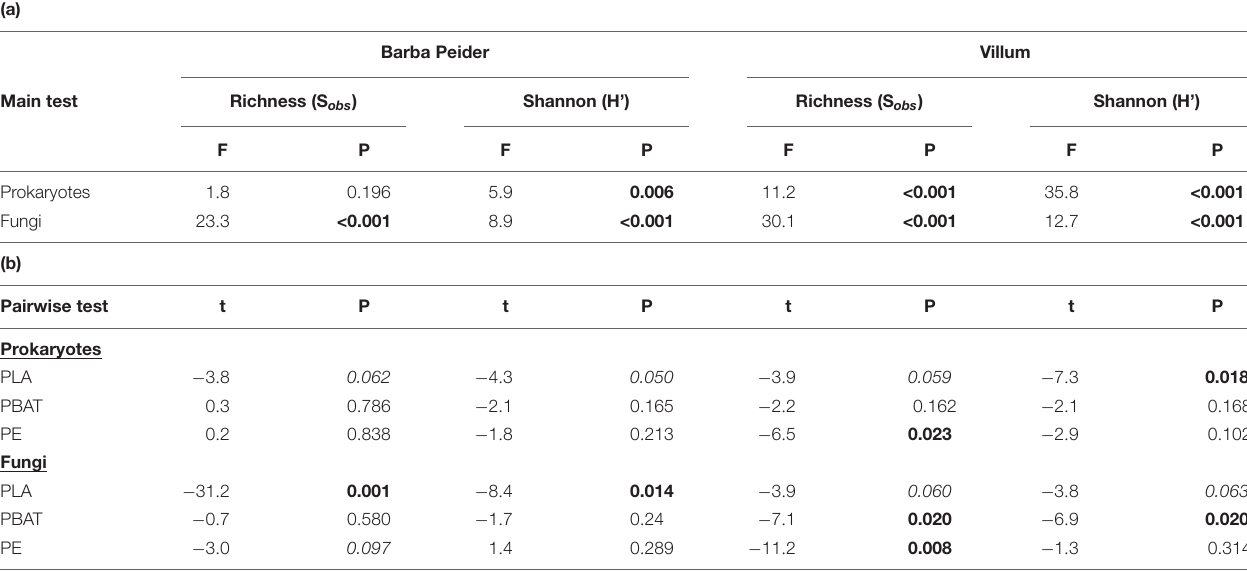
TABLE 3 | α -diversity of prokaryotes and fungi in the plastisphere and bulk soil of Barba Peider and Villum soils.